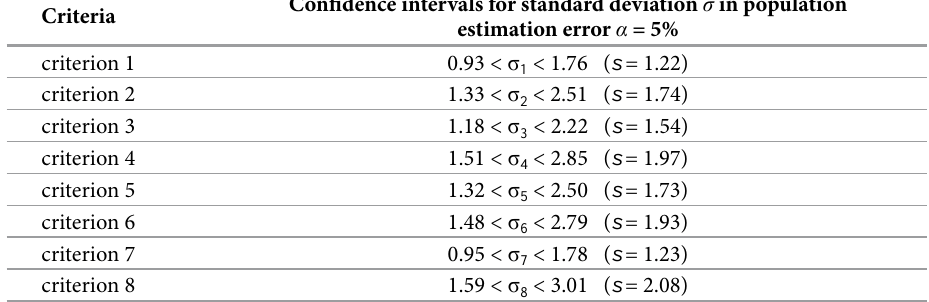
Table 5. Limits of confidentiality intervals of standard relative deviation for particular criteria